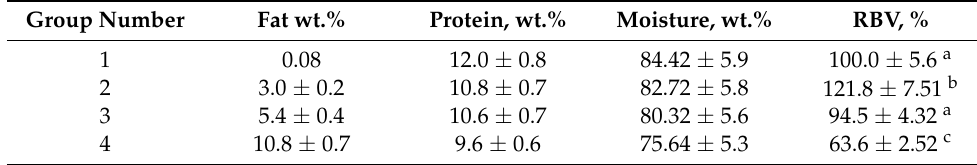
Table 10. Physical and chemical properties of curd product samples. a–c : Different letters mark statistically significant RBV mean differences.